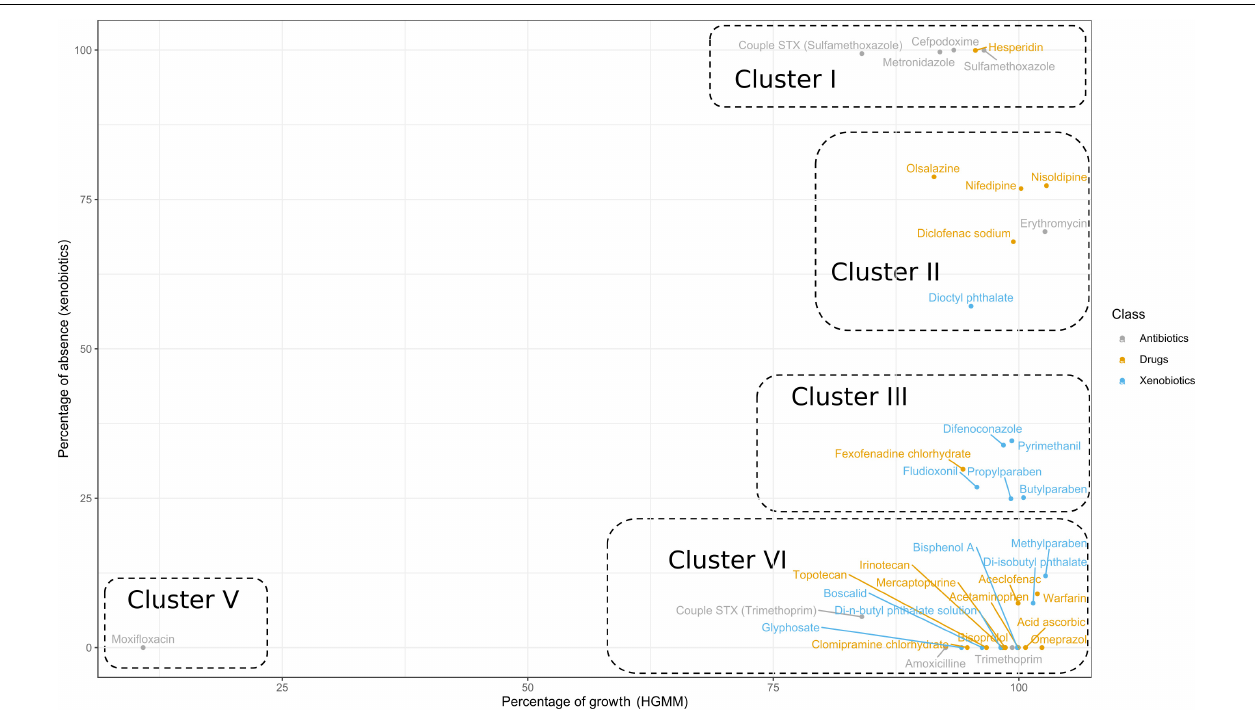
FIGURE 5 | Human gut microbiota model bacterial growth versus absence of the native antibiotics, drugs and xenobiotics. Biplot showing the percentage of bacterial growth of the HGMM versus the percentage of absence of the native molecules in the HGMM culture supernatant. The percentage of bacterial growth of the HGMM was calculated in the presence of antibiotics, drugs and xenobiotics compared to HGMM cultures without molecule. The percentage of absence of native antibiotics, drugs and xenobiotics in HGMM culture supernatant were calculated from the respective control cultures without HGMM bacterial community. STX (sulfamethoxazole) and STX (trimethoprim) indicate that only sulfamethoxazole or trimethoprim was analyzed,